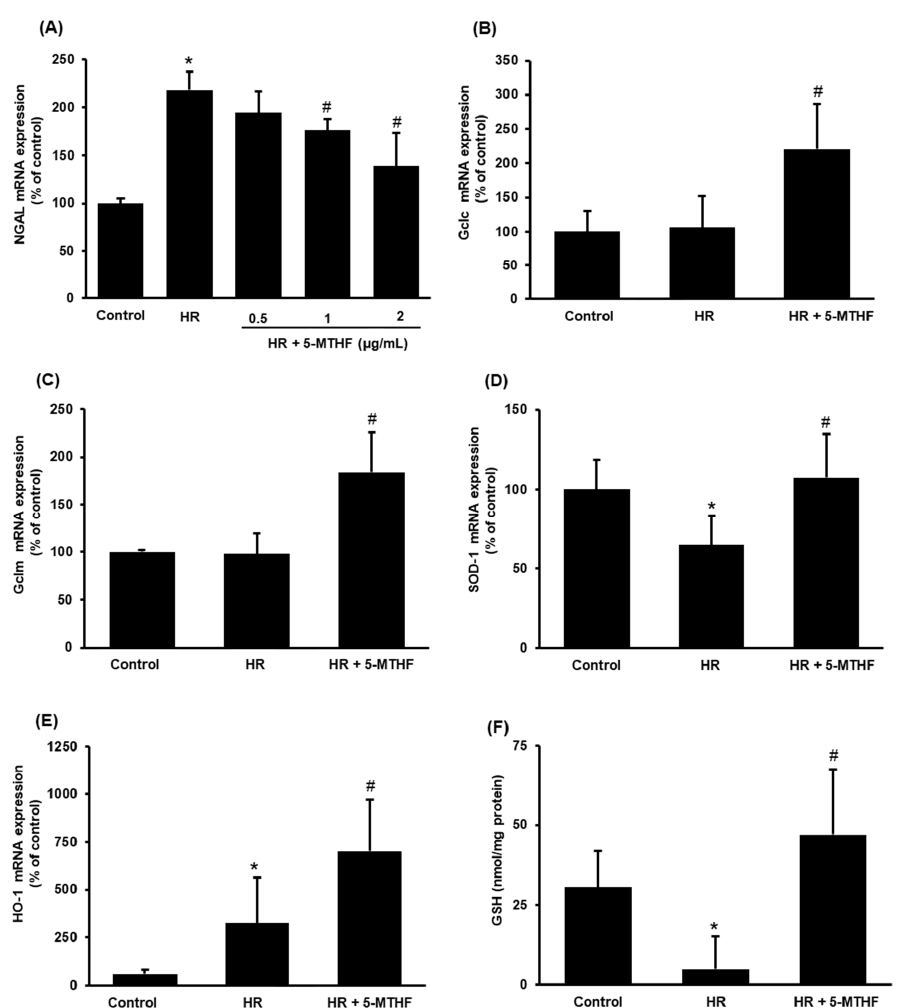
Figure 5. The expression of NGAL and glutathione synthesizing enzyme expression in proximal tubular cells. Tubular cells were subjected to 2 h hypoxia, followed by reoxygenation (HR) for 12 h